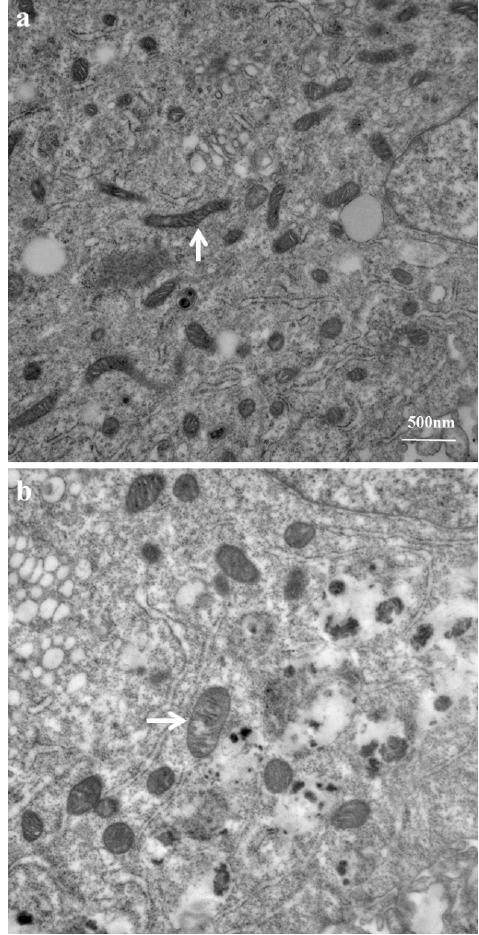
Figure 3. Azithromycin caused swollen and vacuolated mitochondria in MCF-12A cells. ( a ) control; ( b ) azithromycin 94 µg/mL for 7 days; arrow: mitochondria. ( b ) azithromycin 94 µ g / mL for 7 days; arrow: